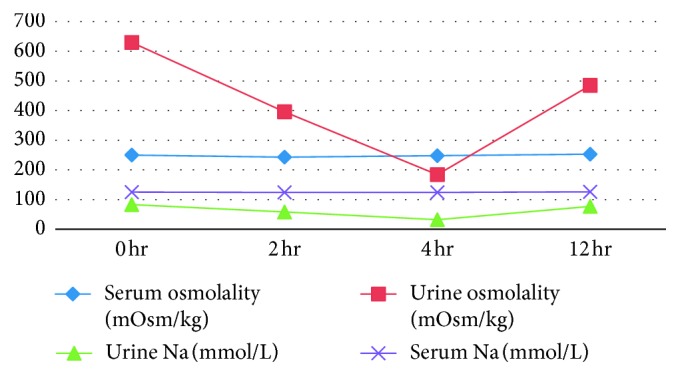
Water load test.